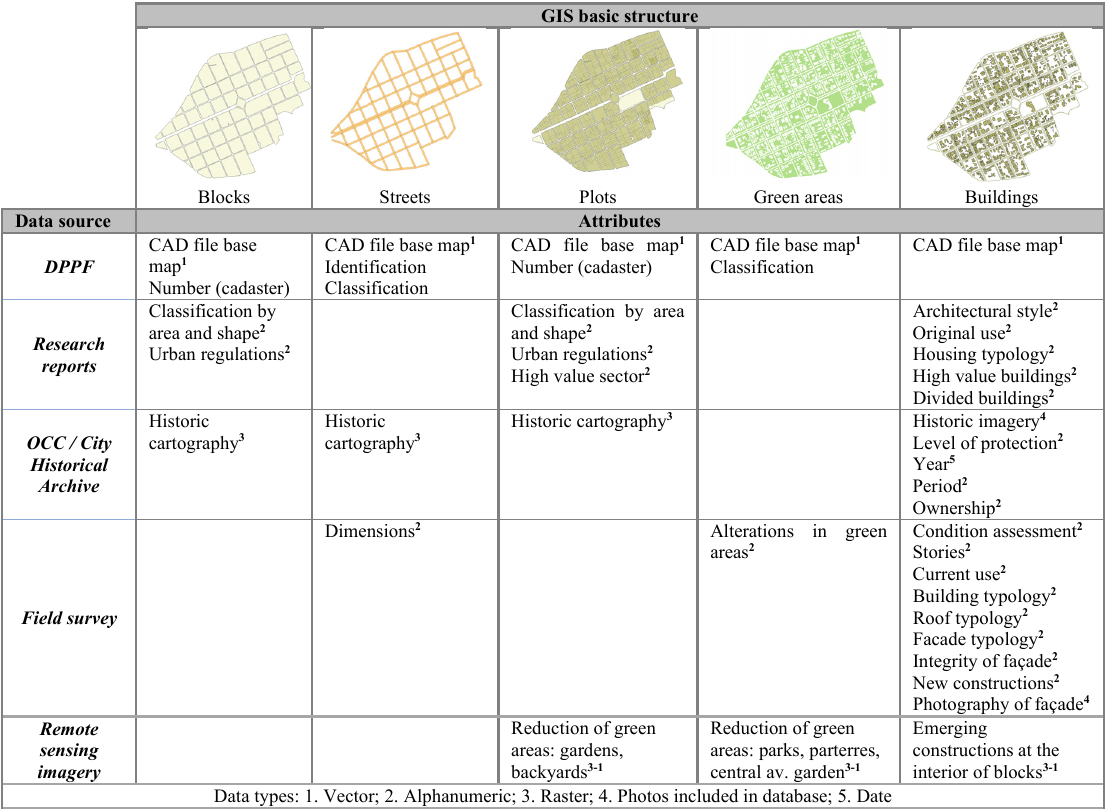
Table 4. General GIS structure according to layers, attributes and data